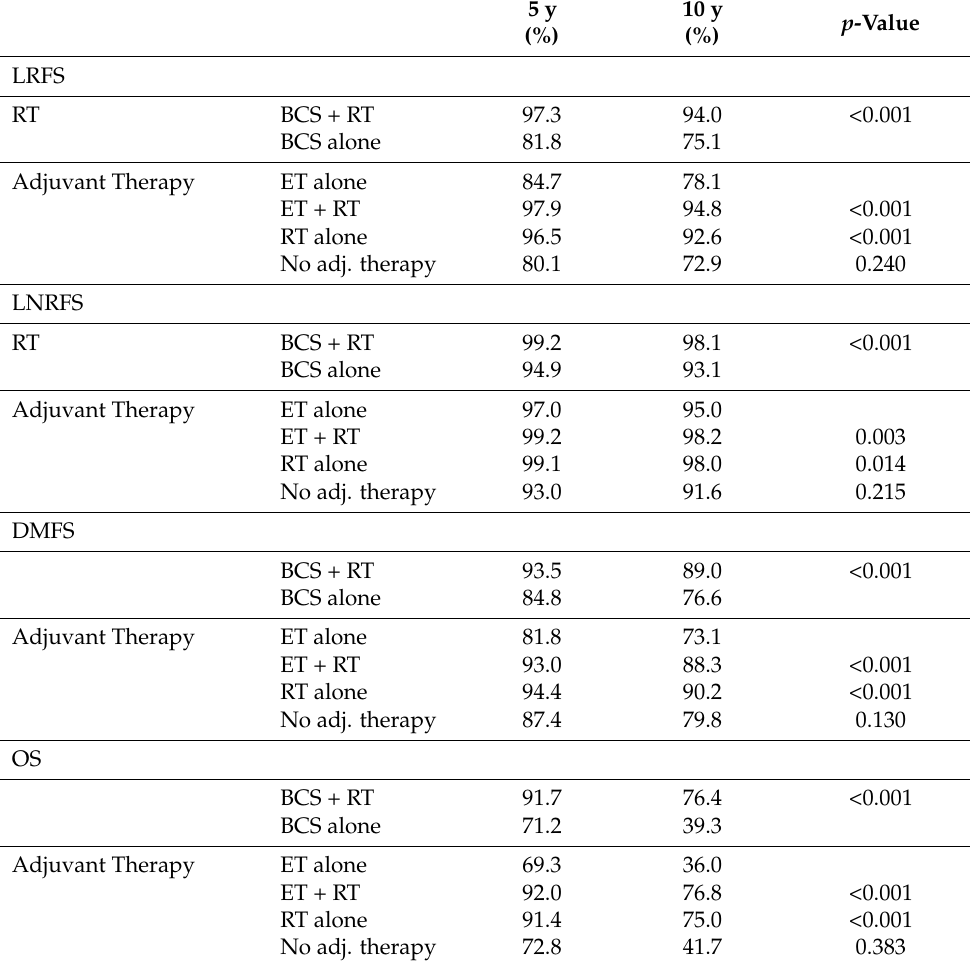
Table 3. Kaplan–Meier estimates of local recurrence-free survival (LRFS), lymph node recurrence-free survival (LNRFS), distant metastasis-free survival (DMFS), and overall survival (OS) for patients with invasive tumors ( n = 2684) following breast-conserving surgery (BCS). y: years; RT: radiation therapy; ET: endocrine therapy; adj. therapy: adjuvant therapy. 5 y